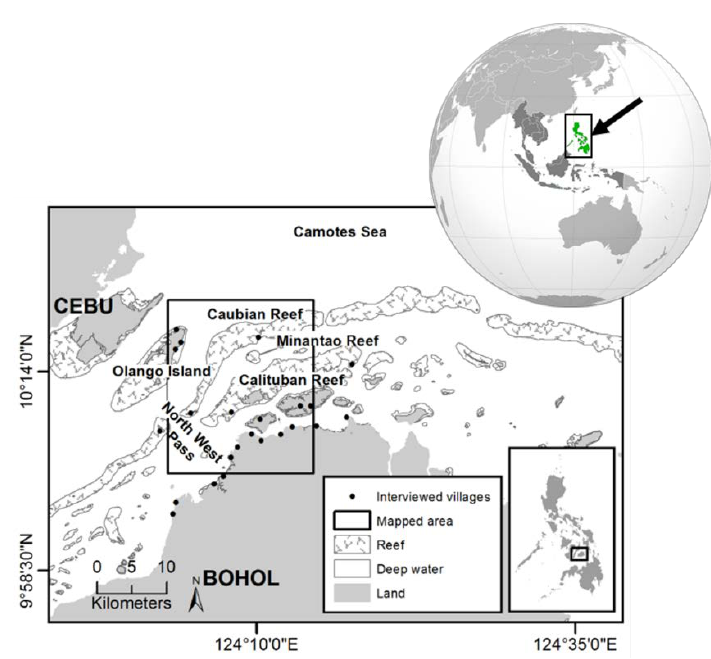
Figure 2. Danajon Bank coral reef in the Central Visayas, Philippines, where fishers were interviewed to create long-term maps of fishing grounds, as shown in Figure 3. The study area, within which respondents mapped their fishing grounds, is outlined by the black box. The 418.0 km 2 (19 × 22 km) study area contained 354.1 km 2 of ocean.